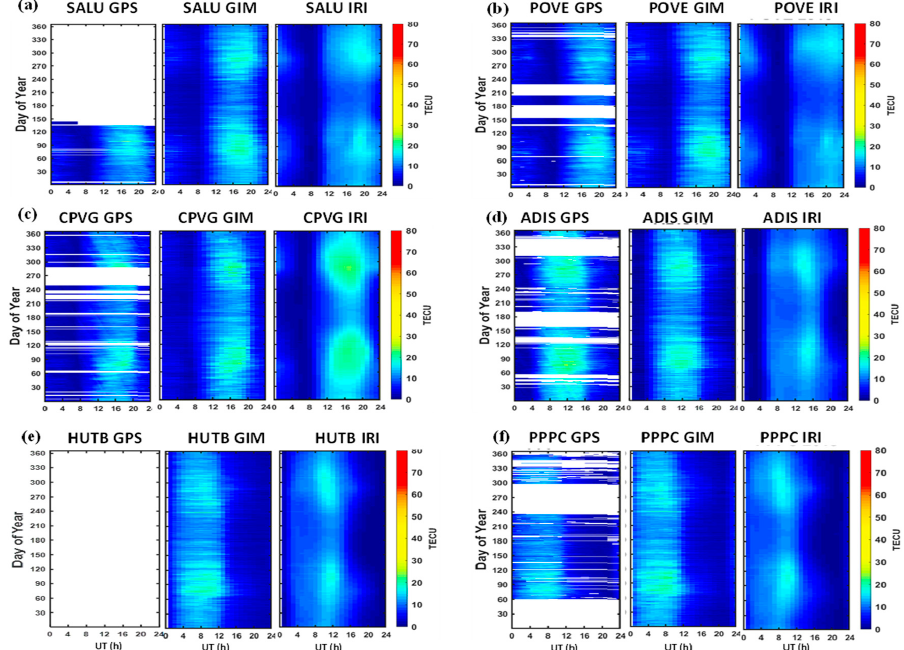
Figure 4. Diurnal variations in GPS-TEC and assessment of GIM and IRI-2016 models at the American (GPS stations: ( a ) SALU and ( b ) POVE), African (GPS stations: ( c ) CPVG and ( d ) ADIS), and Asian (GPS stations: ( e ) HUTB and ( f ) PPPC) longitudes for the year 2018. The details of the GPS stations are mentioned in Table